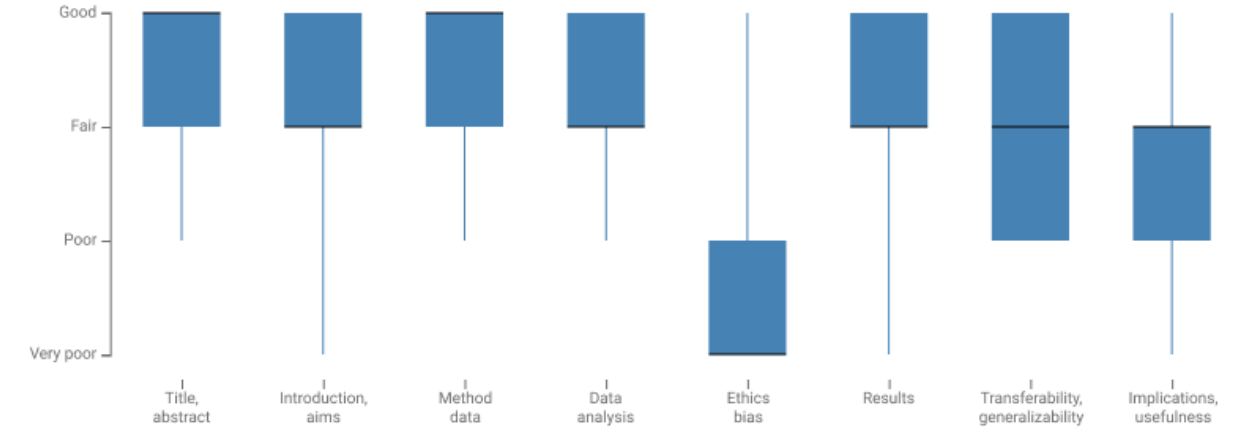
Figure 2. Distribution of the quality assessment using Hawker